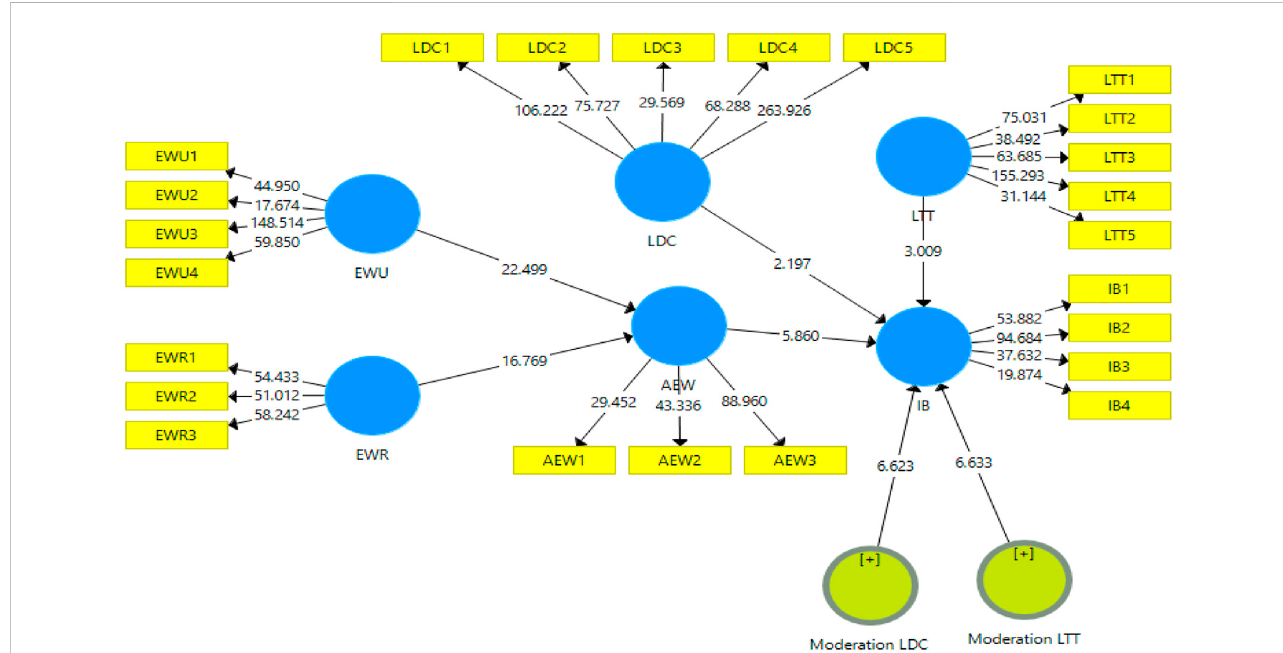
FIGURE 3 Structural model. EWU, E-wallet Usefulness; EWR, E-wallet Risk; AEW, Adopting E-wallet; IB, Impulsive Buying; LDC, Low Distribution Charges, and LTT, Low Transit Time.